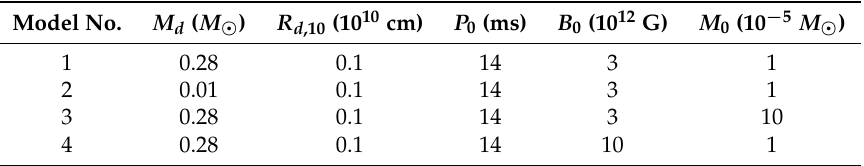
Table 1. Model parameters for the initial fall-back